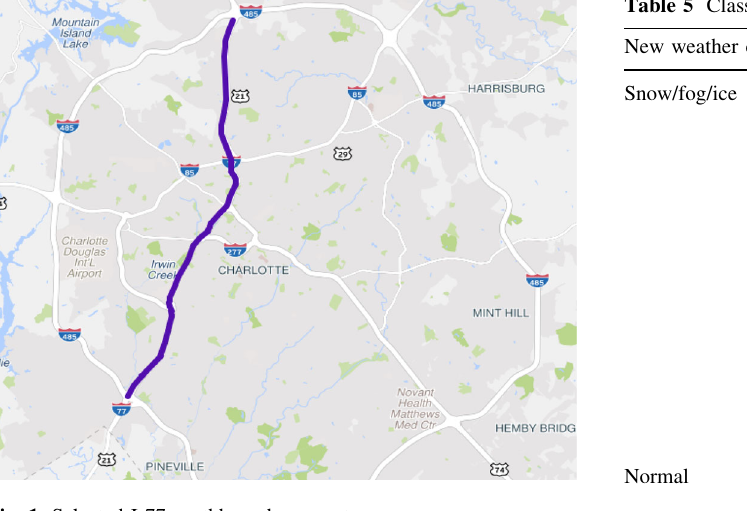
Fig. 1 Selected I-77 southbound segments Table 4 Sample raw travel time data